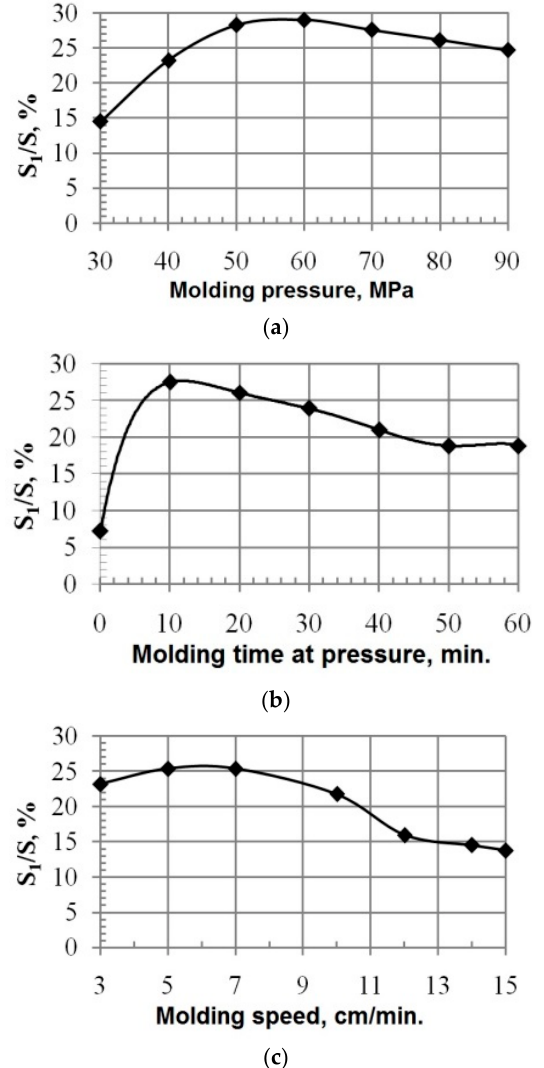
Figure 9. Adhesive durability of CFRP depending on technological modes of pressing process ( S 1 —surface area of ruptures; S —nominal area of sample): ( a ) molding pressure; ( b ) molding time at pressure; and ( c ) molding speed.